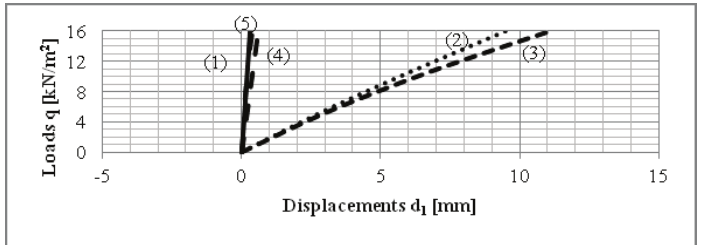
Fig. 6d. Displacements d x (mm) depending on the use of sheet piles as a cover of the foundation. Horizontal load applied at the bearing points